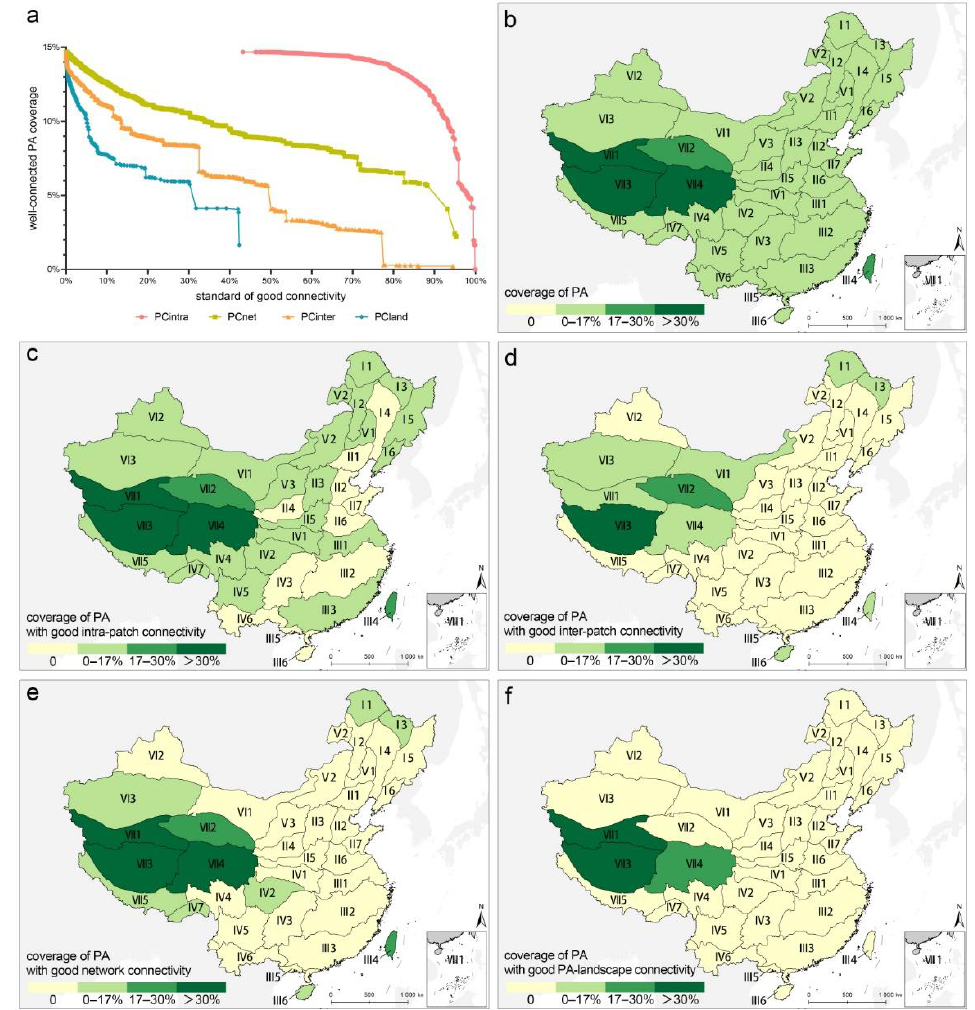
Figure 6. ( a ) Relationship between the standards of connectivity indicators to determine good PA connectivity and the well-connected PA coverage in China, including PCintra, PCinter, PCnet and PCland. ( b ) The PA coverage of ecological zones in China. ( c ) The well-connected PA coverage of ecological zones in China based on intra-patch connectivity. ( d ) The well-connected PA coverage of ecological zones in China based on inter-patch connectivity. ( e ) The well-connected PA coverage of ecological zones in China based on network connectivity. ( f ) The well-connected PA coverage of ecological zones in China based on PA–landscape connectivity.